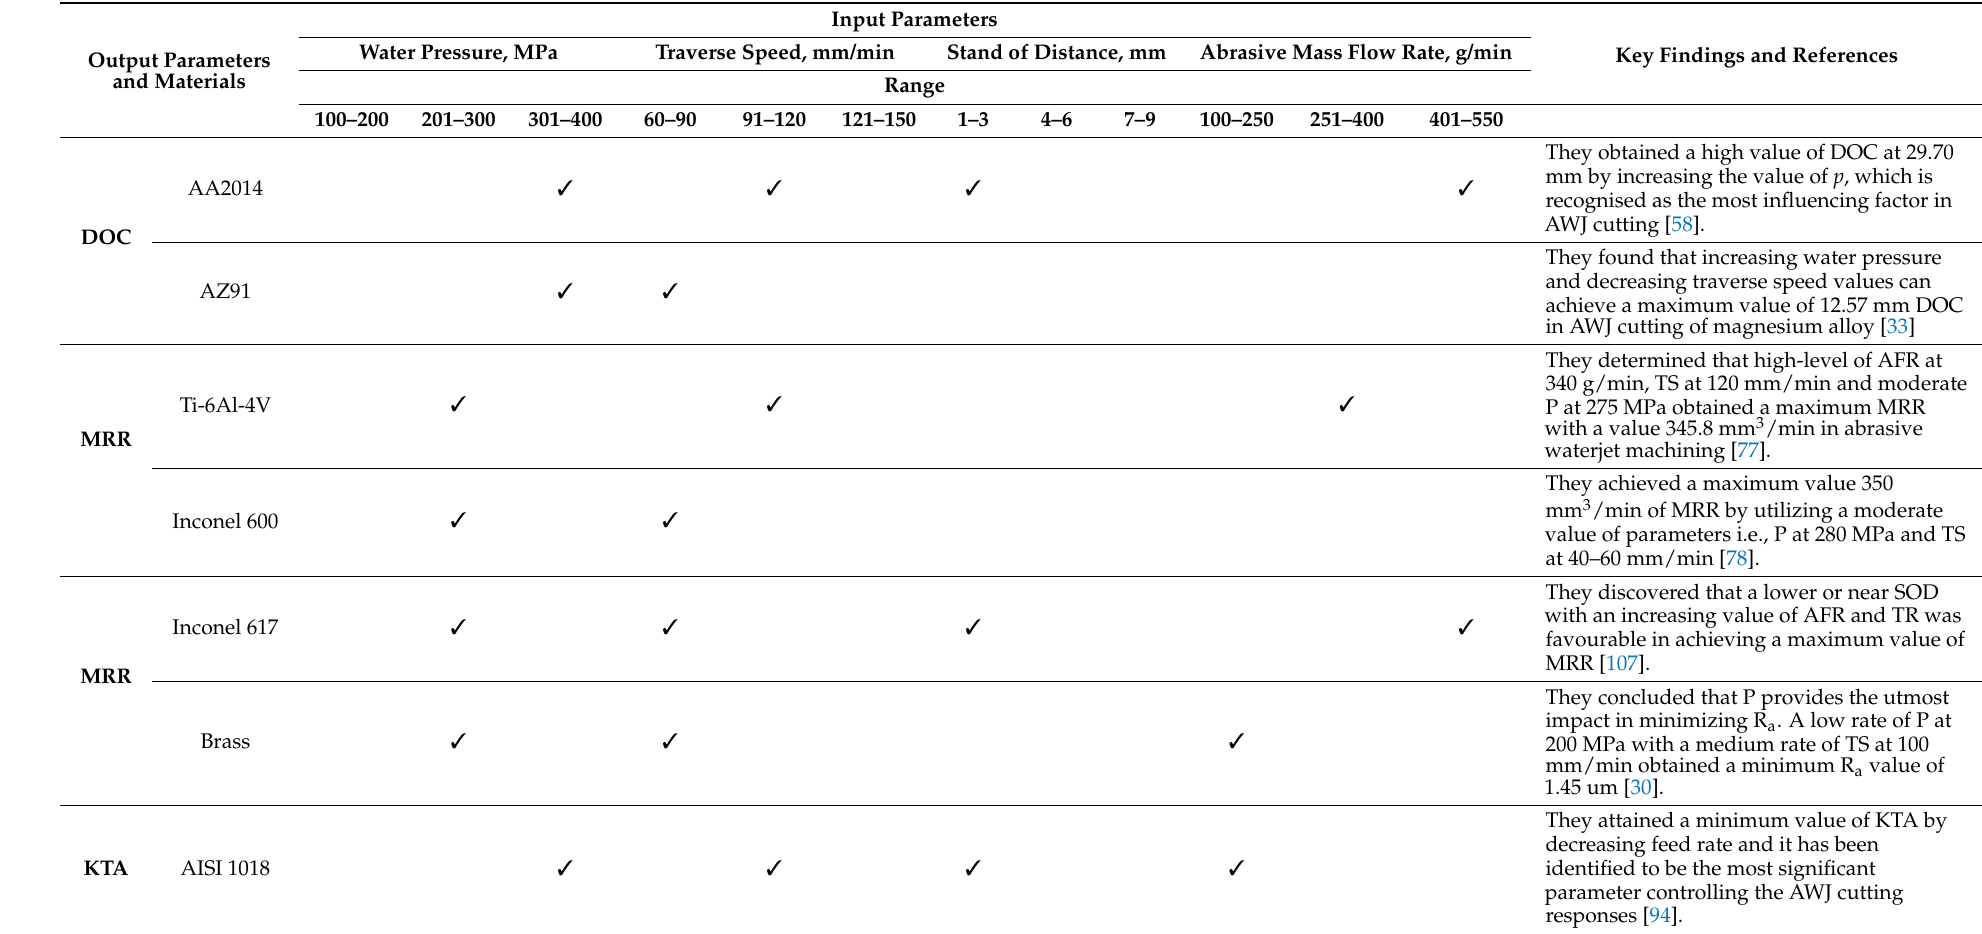
Table 8. Impacts of the most influencing process parameters in AWJ cutting output